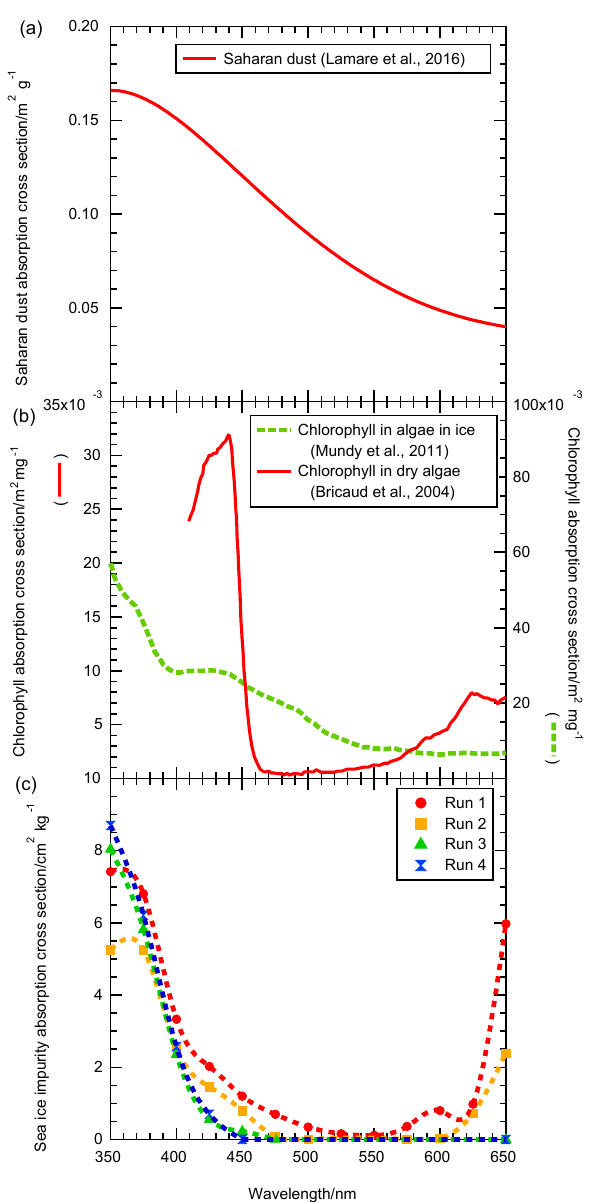
Figure 9. (a) Absorption cross section of Saharan dust taken from Lamare et al. (2016). (b) Absorption cross sections of chlorophyll. Chlorophyll in ice (dashed line) taken from Mundy et al. (2011) is per milligram of algae determined by fluorescence. Chlorophyll (solid line) is taken from Bricaud et al. (2004) and is per milligram of dry weight cells. (c) Wavelength-dependent absorption cross sec- tion derived from reflectance and e -folding depth data from runs 1 to 4 for the undoped ice. A smooth line is added to guide the eye. Values for run 4 are too small to plot clearly at longer wavelengths. Error bars show the possible variation in absorption cross section obtained from different fits of the original reflectance and e -folding depth